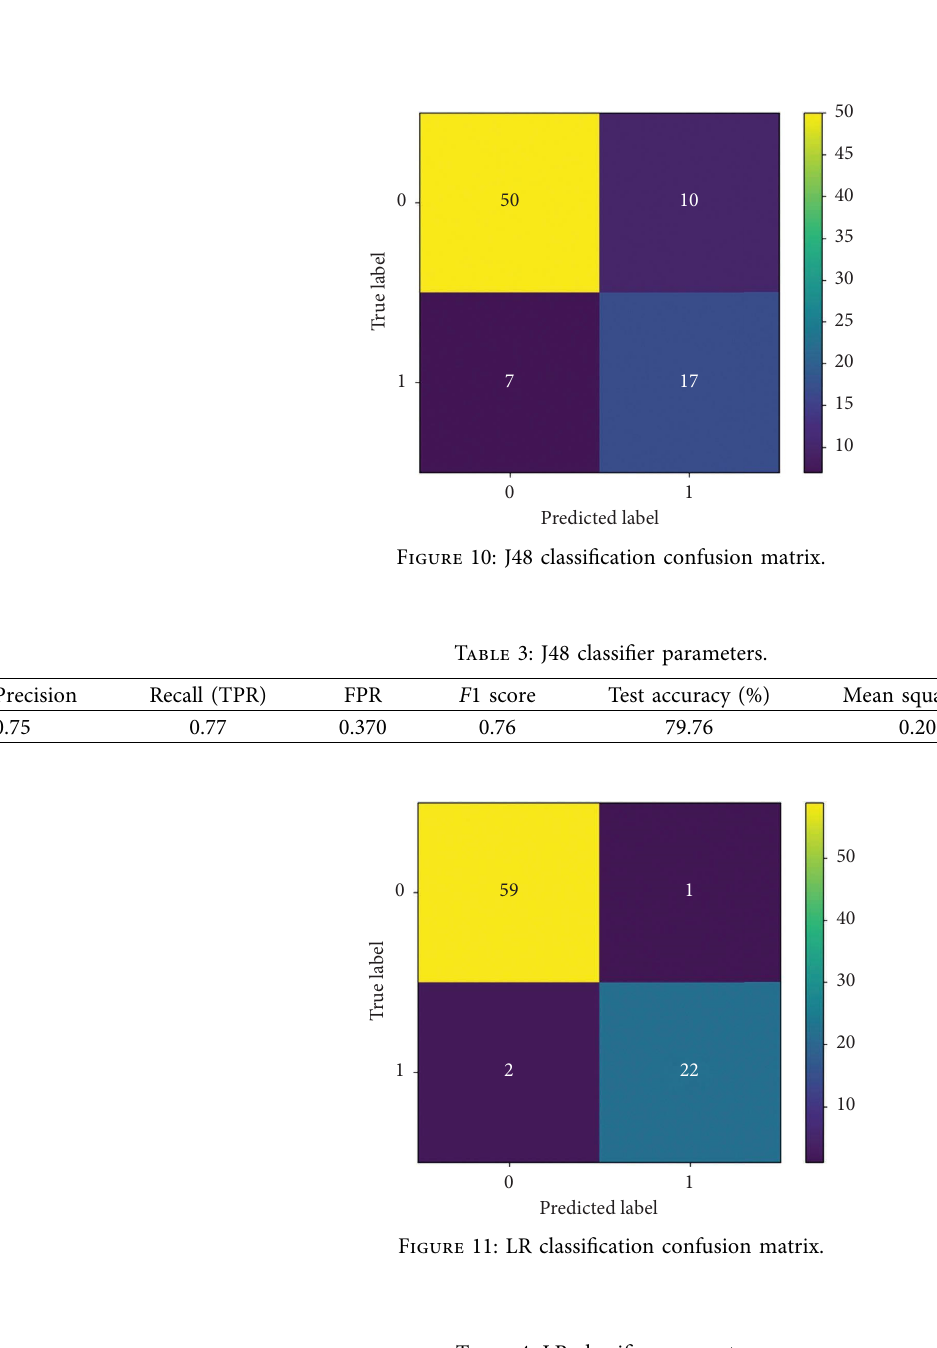
Table 4: LR classifer